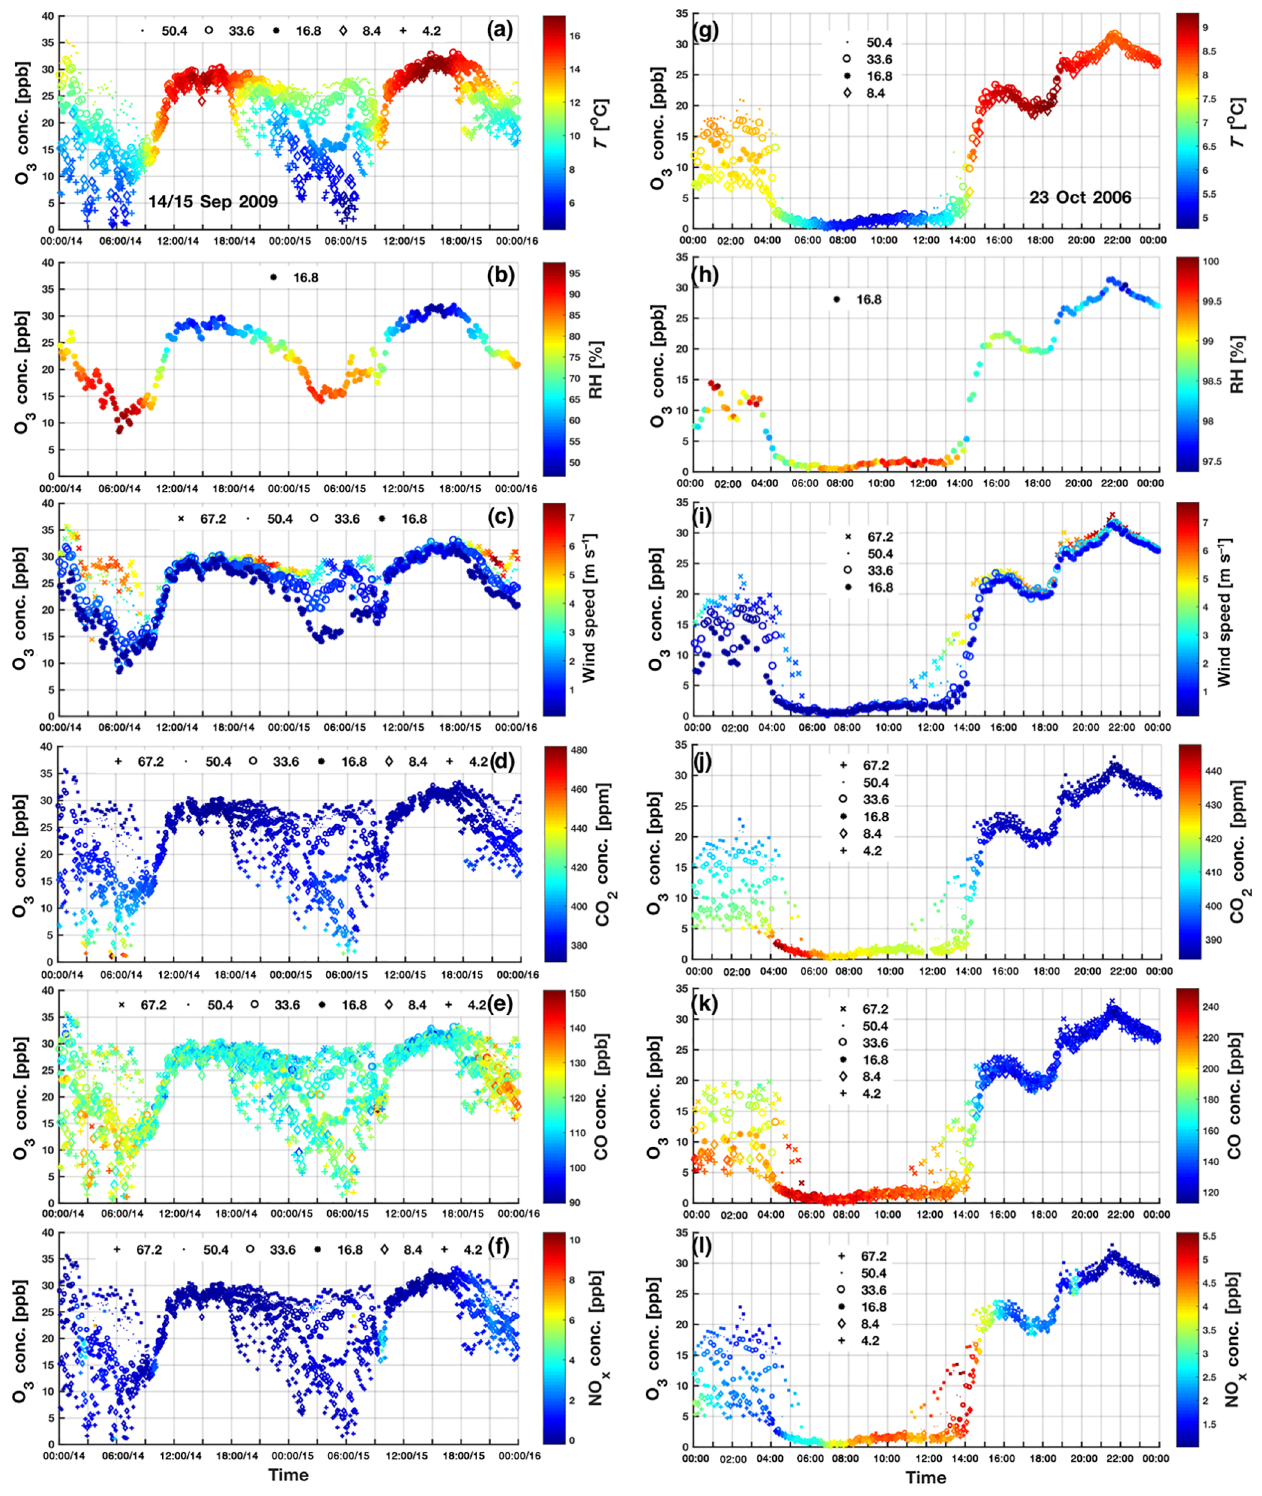
Figure 10. The influence of (a, g) air temperature ( T ), (b, h) relative humidity (RH), (c, i) wind speed, (d, j) carbon dioxide (CO 2 ) con- centration (e, k) carbon monoxide (CO) concentration, and (f, l) nitrogen oxides (NO x ) concentrations on the evolvement of the ozone concentration along time. Left column: a near-surface depletion event on 14–15 September 2009. Right column: a full-profile depletion event on 23 October 2006.